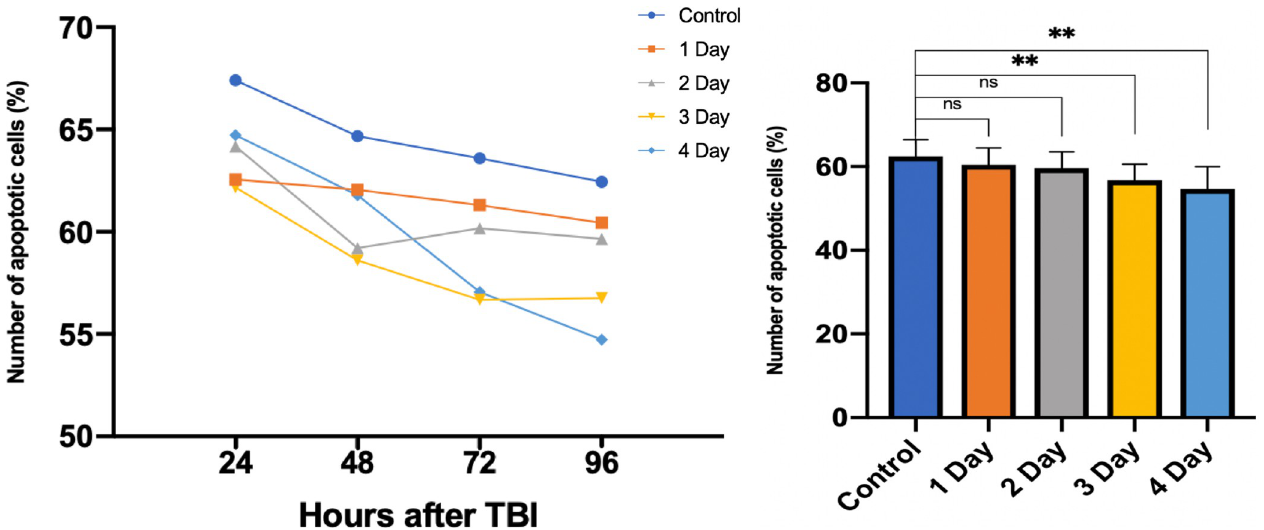
Fig 7. Effect of daily doses of irradiation on cell loss of LT2 (42.4mW/cm 2 ) for 1 minute per day, for 1 to 4 days. ns denotes no significance, �� denotes P < 0.01, error bars represent SD.